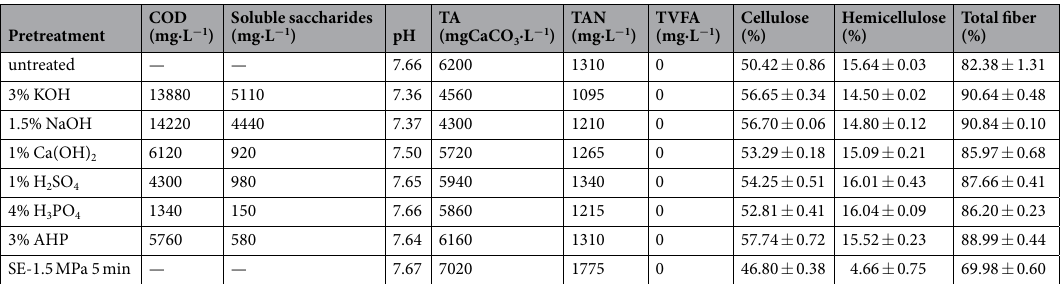
Table 3. Characteristics of pretreated CS, pretreatment solution after pretreatment and biogas slurry after AD a . a Results are the average and their standard error of triplicate